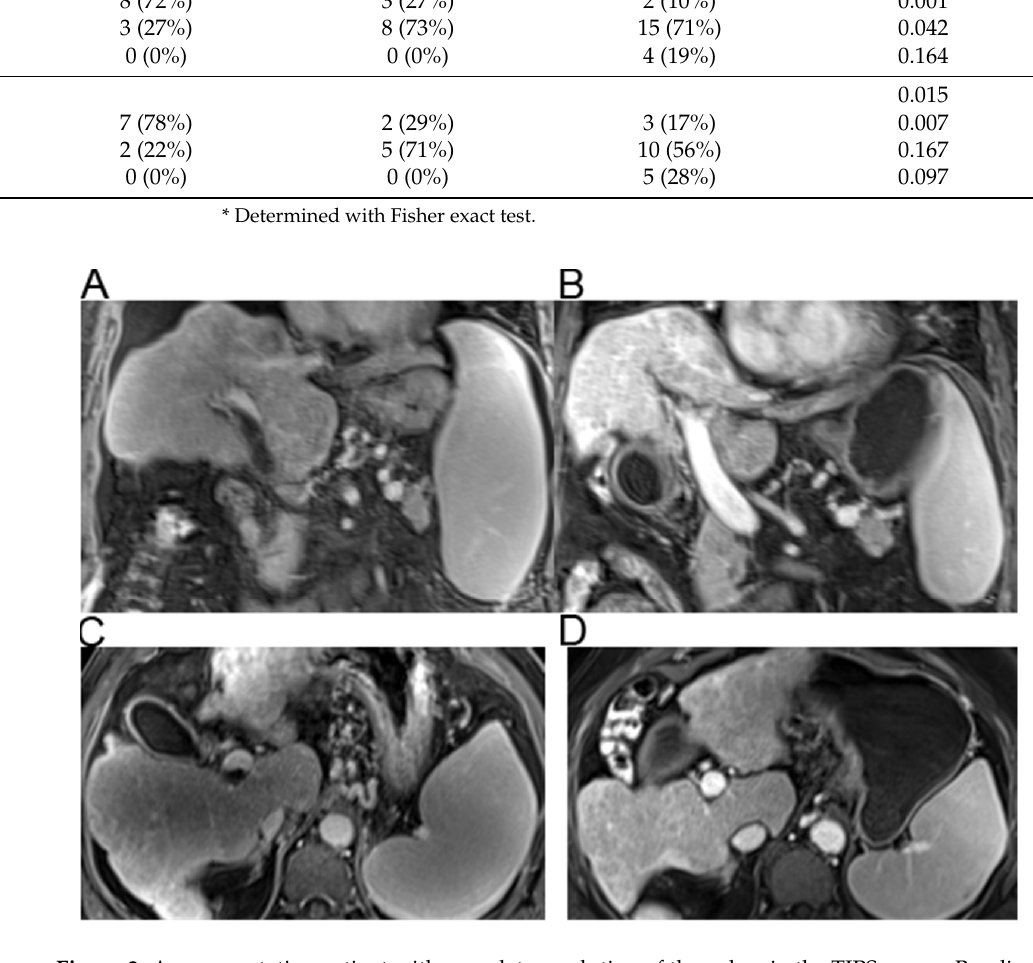
Figure 2. A representative patient with complete resolution of thrombus in the TIPS group. Baseline ( A ) coronal and ( C ) axial imaging 2 months before TIPS showing significant portal vein thrombosis (25–50% occlusion). Follow-up ( B ) coronal and ( D ) axial imaging 6 months after TIPS showing complete resolution of the main portal vein thrombosis.